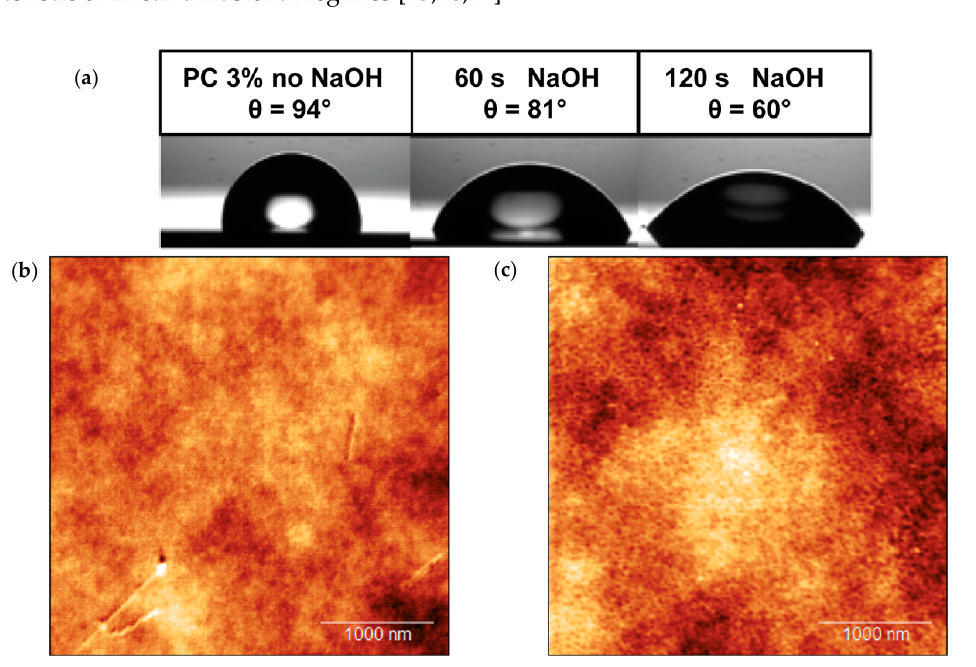
Figure 3. ( a ) Water contact angle measurement done on the bare PC surface and after the treatment with NaOH for 60 and 120 s. ( b ) Atomic force microscopy (AFM) images of the polycarbonate surface of the NEA before functionalization and ( c ) after gliadin adsorption.